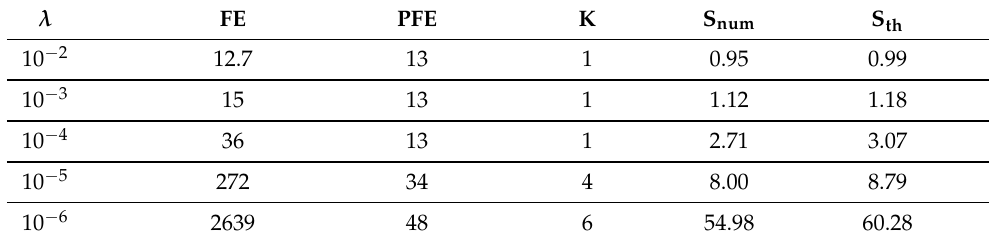
Table 7. Dam break test case runtime and speed using FE and PFE schemes for different λ and constant n x = 1000 and N = 2 shows increasing speedup close to the theoretical